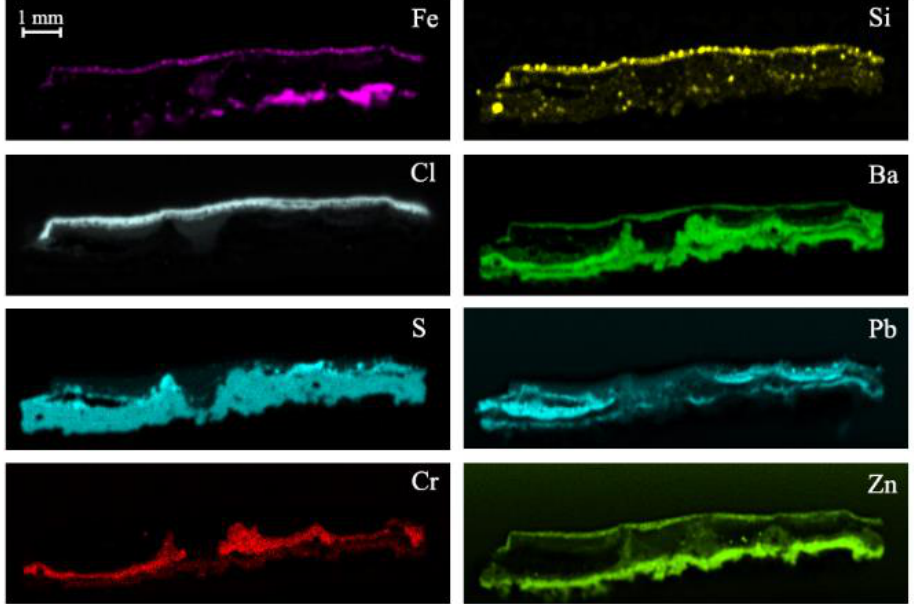
Figure 5. Micro-energy-dispersive X-ray fluorescence spectroscopy ( µ -EDXRF) maps of the sample SUBS-3b from a black area. Table 1. EDXRF elemental data (wt.%) of sub sample SUBS-3b.